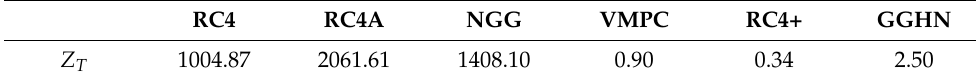
Table 2. Values of Z T for each cipher.